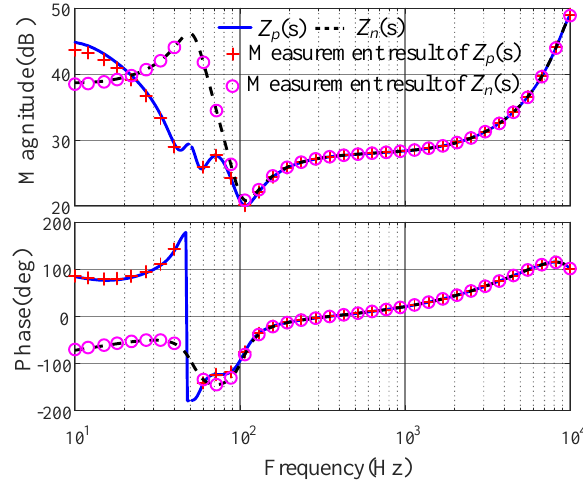
Figure 2. Sequence impedance of the grid-connected inverter.